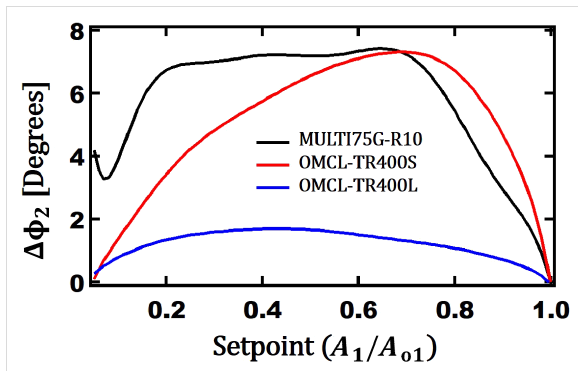
Figure 12: Simulation results of three commercial cantilevers in bimodal AFM done on Au and PS polymers. Vertical axis: the second eigenmode phase difference between Au and PS. Horizontal axis: first eigenmode setpoint. Black: MULTI75G, red: TR400Short, and blue: